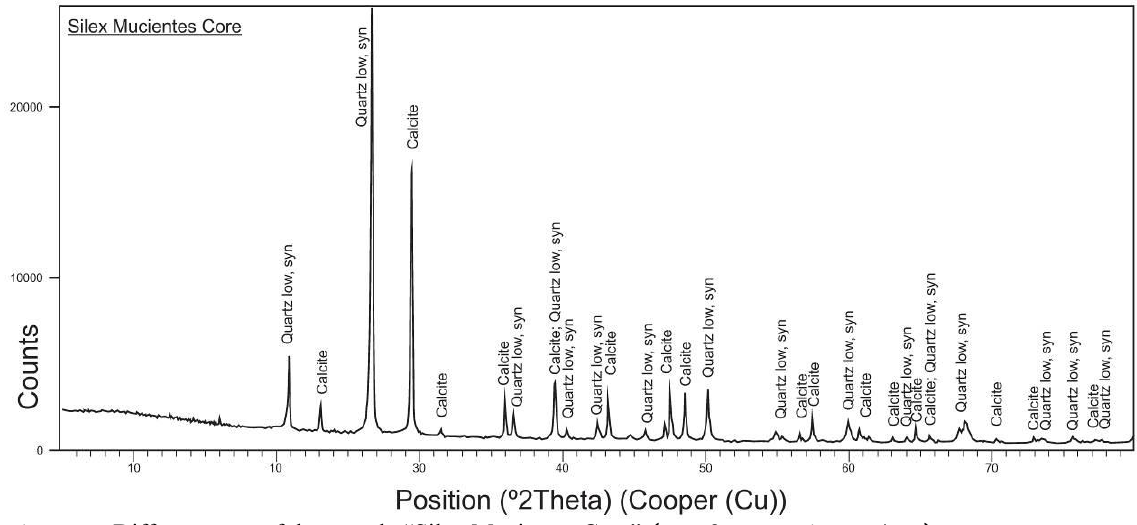
Figure 15. Diffractogram of the sample “Silex Mucientes Core” (core from Mucientes chert). Table 3. Chemical analysis data from X-ray fluorescence analysis (weight % and ppm). Abbreviations: d.l. = detection limit; <d.l. = below detection limit; LOI = loss on ignition. LOI(1) = stoichiometrically CO2% inferred from CaO%, assuming that all CaO comes from calcite (CaCO3). LOI(2) = LOI - LOI(1) ≈ organic